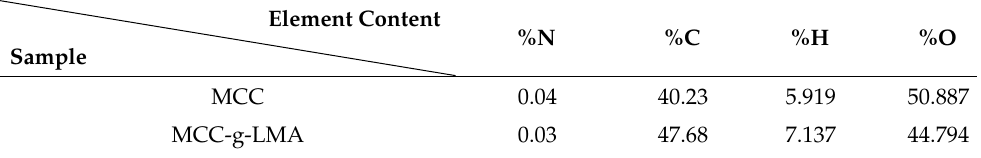
Table 3. Elemental analysis results of MCC and